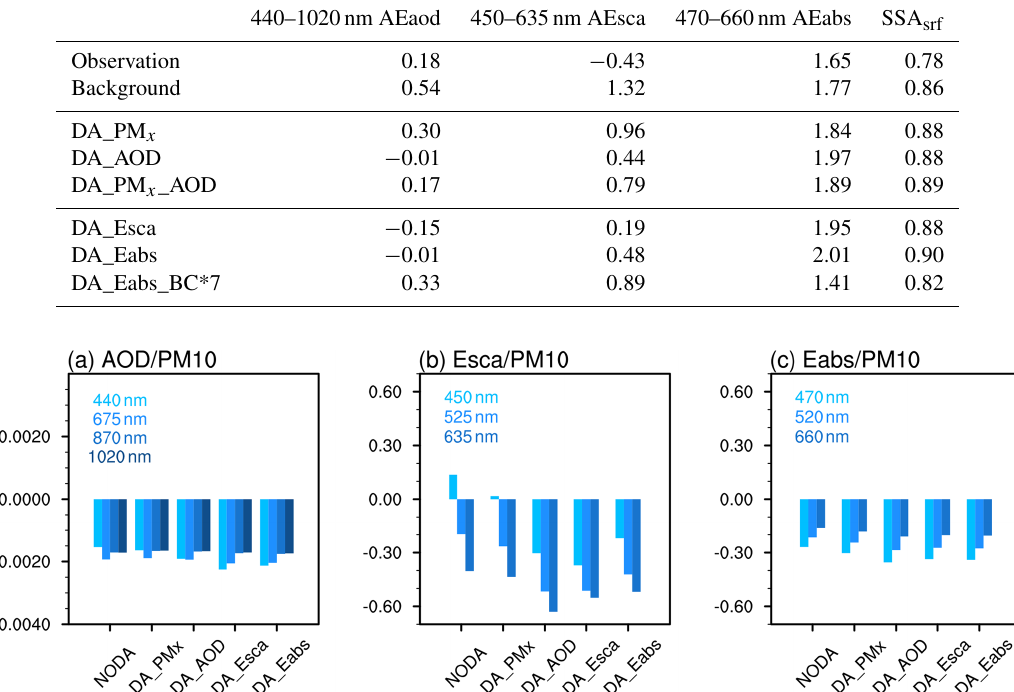
Table 3. The Ångström exponent values based on the AOD (440 and 1020nm; AEaod), aerosol scattering coefficients (450 and 635nm; AEsca), aerosol absorption coefficients (470 and 660nm; AEabs), and the surface single-scattering albedo